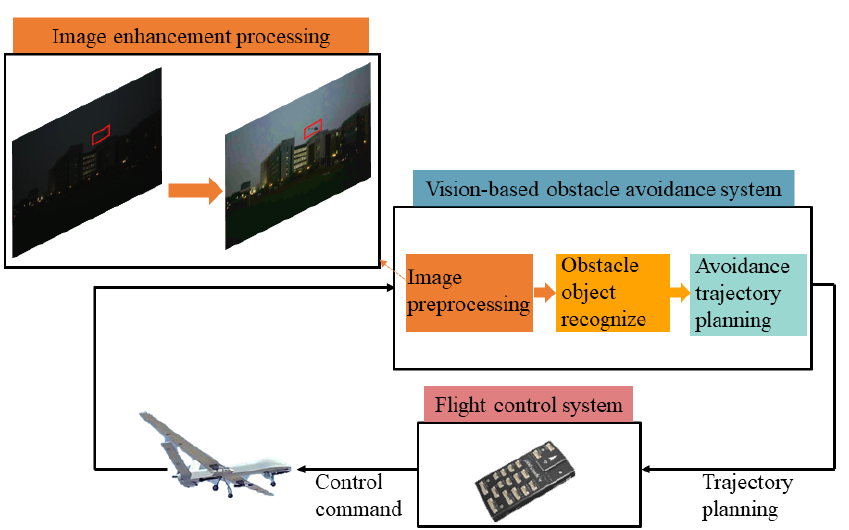
Figure 1. Constructure of vision-based obstacle perception and avoidance